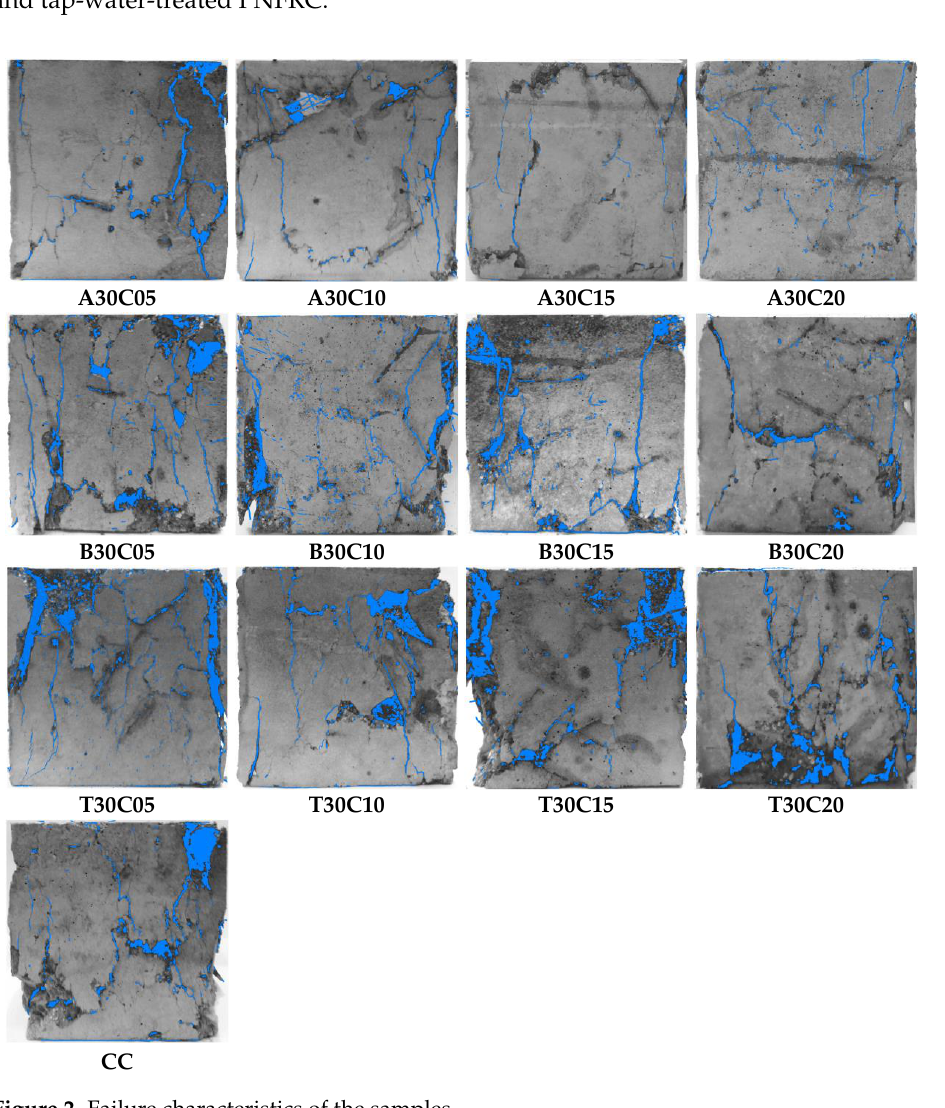
Figure 2. Failure characteristics of the samples. The fractal dimension is used to evaluate the failure morphology of concrete with three treatments. Figure 3 shows the fractal dimension of cracks of pine needle fiber-rein- forced concrete specimens. In general, the fractal dimension of alkali-treated PNFRC is slighter than that of the CC specimen, while the fractal dimension of boiling-water-treated and tap-water-treated fiber concrete is much greater than that of the plain concrete, which is consistent with the macro results of a damaged morphology.